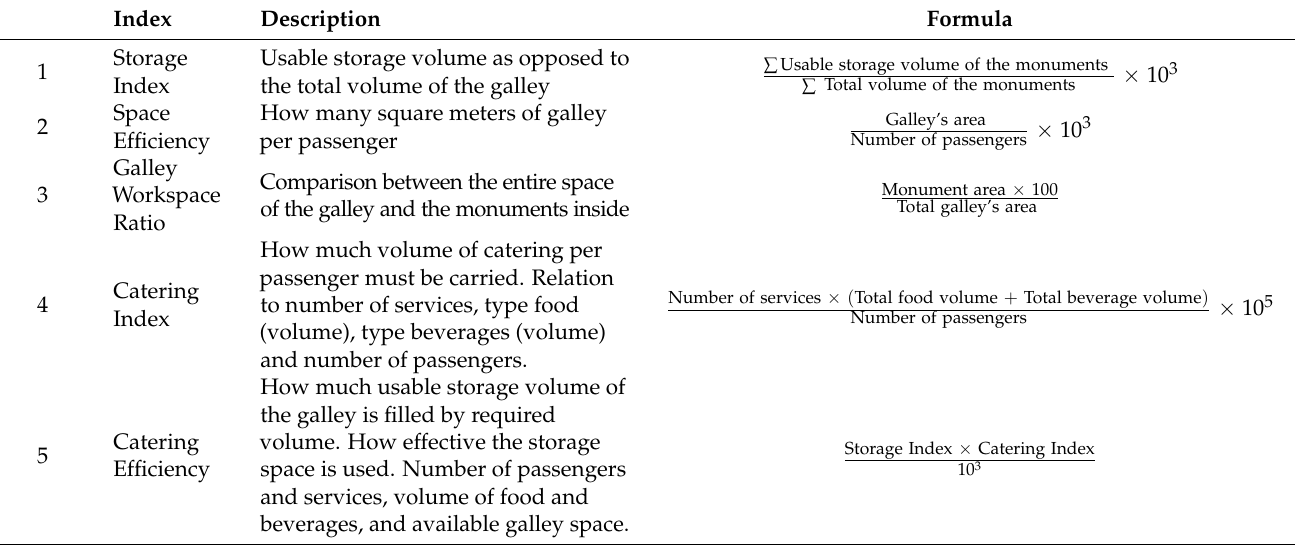
Table A6. Comparison Indexes for ICS automation